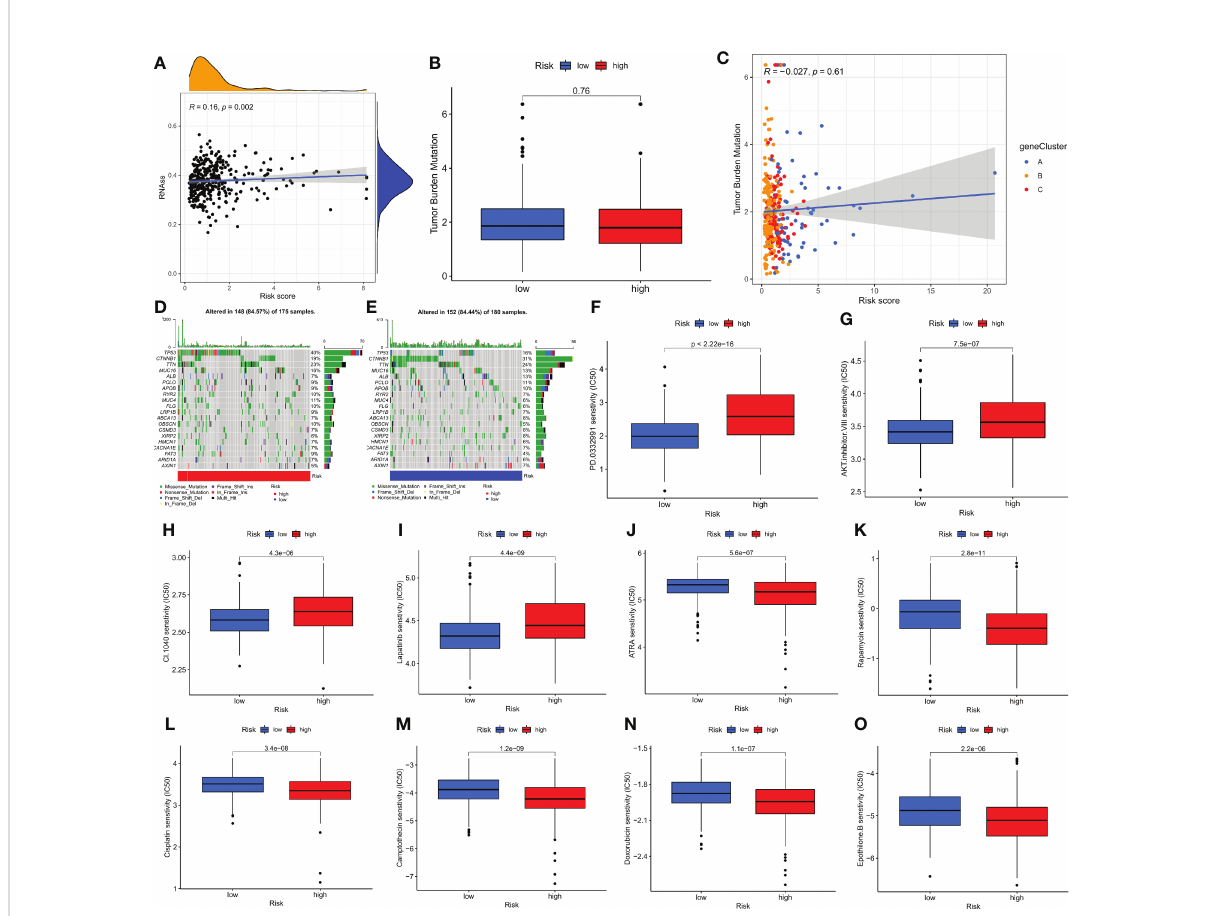
FIGURE 6 Comprehensive analysis of the CMPRG_score in HCC. (A) Relationships between CMPRG_score and CSC index. (B) TMB in different CMPRG_score groups. (C) Spearman correlation analysis of the CMPRG_score and TMB. (D, E) The waterfall plot of somatic mutation features established with high and low CMPRG_score. (H – O) Relationships between CMPRG_score and chemotherapeutic